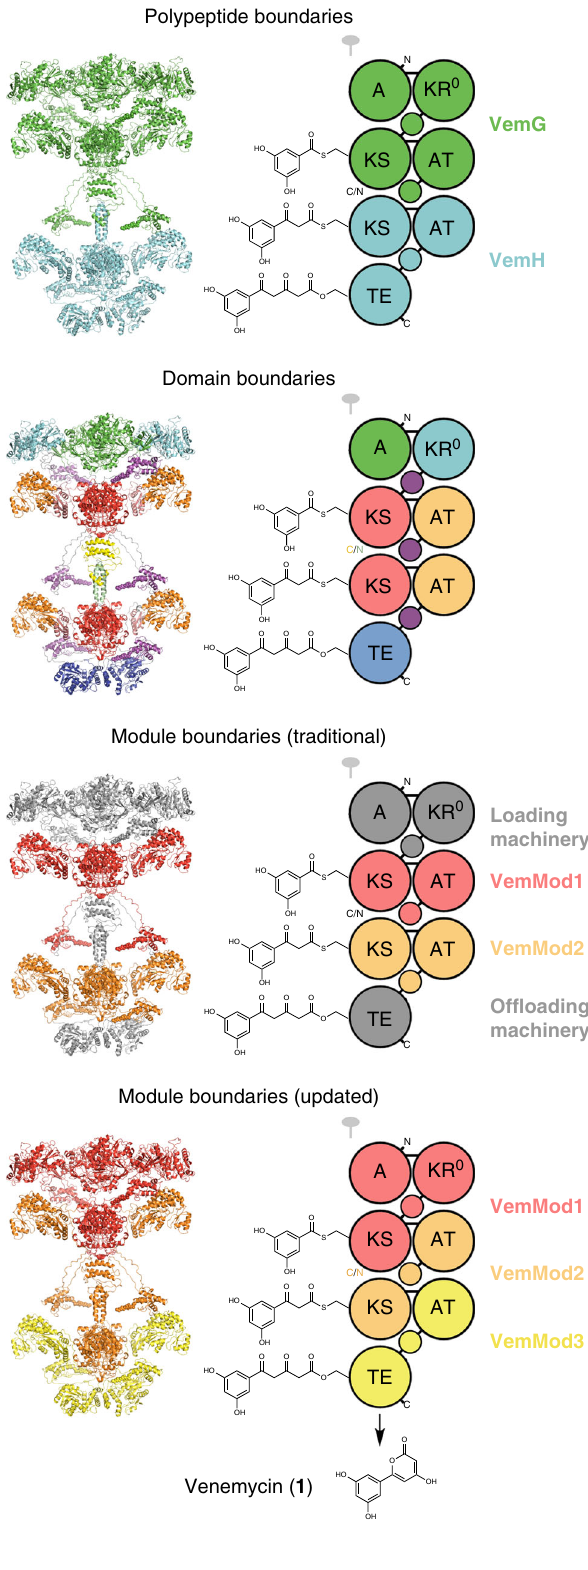
polypeptides, in contrast to cis -AT assembly lines like the pikro- The junction between modules in trans -AT assembly lines is localized on a LPTYPFxxxxxW motif C-terminal to the KS fl anking subdomain 24 (Fig. 1) and is easy to observe in sequence alignments owing to the diverse module types in these synthases 7 . In contrast,